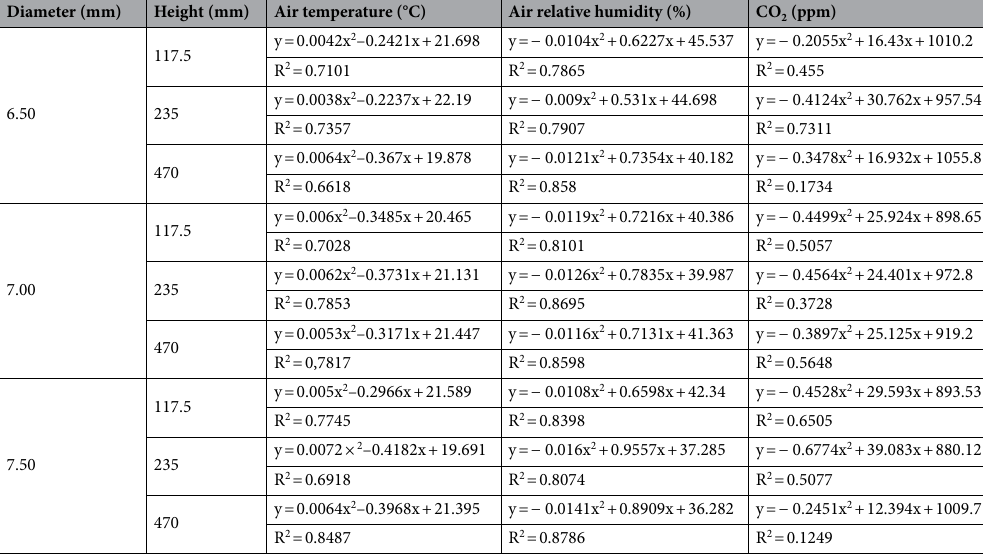
Table 2. Polynomial regression equations for air temperature (°C), air relative humidity (%) and CO 2 (ppm) of corn grain mass at 12% moisture content in tubes with different hole diameters and heights drilling.